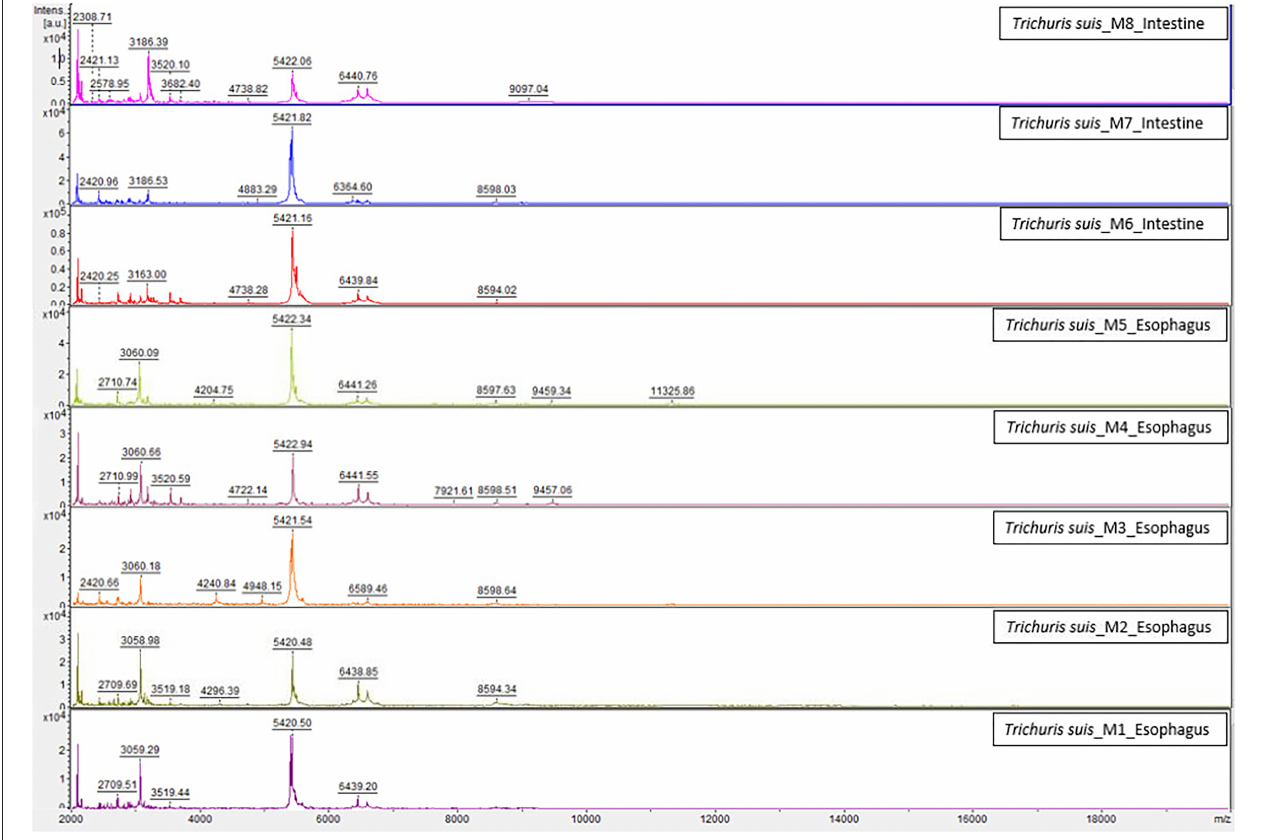
significant differences between esophagus and intestine